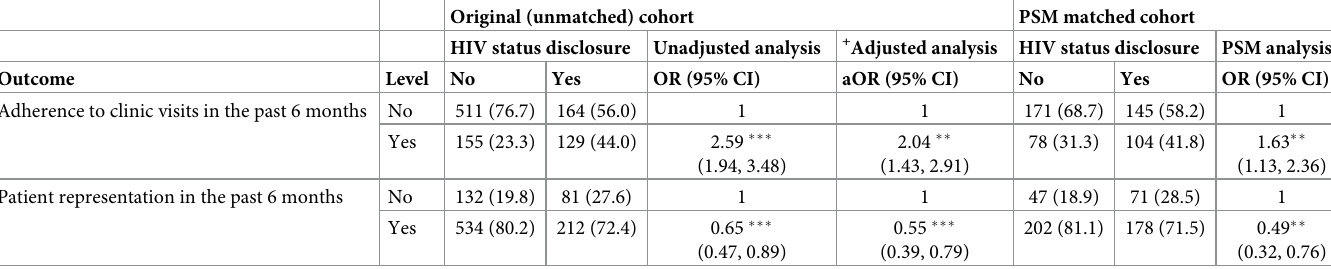
Patient representation in the past 6